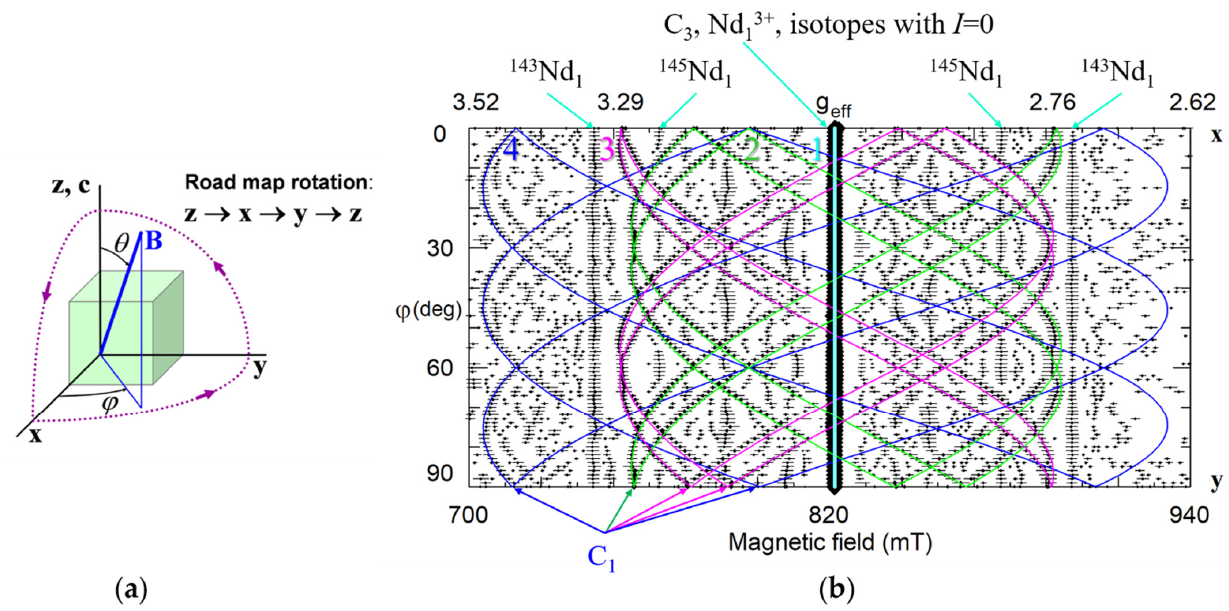
Figure 4. ( a ) The road map rotation corresponds to the following changes of the θ , ϕ angles: θ = 0–90° at ϕ = 0°; θ = 90°, ϕ = 0 − 90°; θ = 0 − 90° at ϕ = 90°. ( b ) Angular dependence of the EPR spectra in xy plane for nearly stoichiometric LN:Nd 3+ . Rhombs represent experimental line positions for Q-band measurements ( ν = 34.445 GHz), their sizes reflect line intensities. Horizontal whiskers near rhombs represent line widths. Cyan, lime, fuchsia, and blue curves represent simulated dependencies for axial Nd 1 , and low-symmetry Nd 2 , Nd 3 , and Nd 4 centers, respectively. Curves for isotopes with nuclear spin I ≠ 0 are not shown.